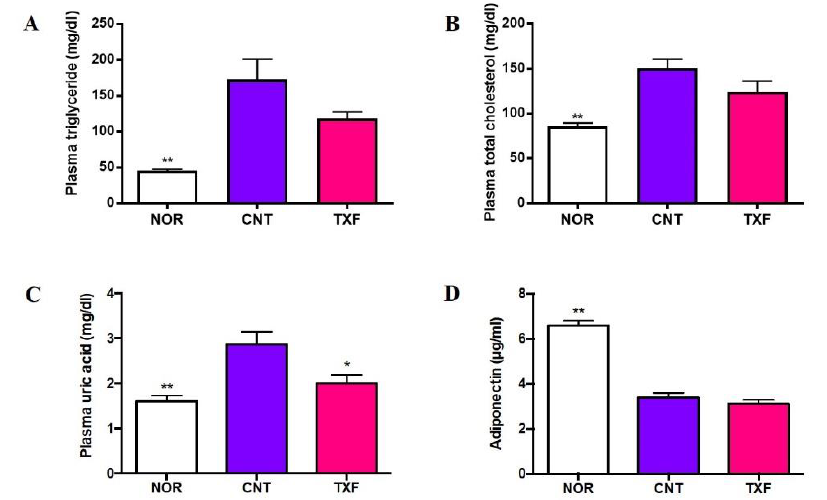
Figure 5. Effect of taxifolin on plasma levels of triglyceride ( A ), total cholesterol ( B ), uric acid ( C ) and adiponectin ( D ) in T2D model KK-A y /Ta mice. At the end of experimental period of four weeks, mice were fasted for 6 h, whole blood was collected from each mouse and plasma sample was prepared. Each value represents the mean ± SEM for eight (Nondiabetic Normal; NOR), seven (Diabetic Control; CNT) or 6 (Diabetic Taxifolin-treated; TXF) mice. *, ** Significantly different from the CNT group at * p < 0.05 and ** p < 0.01, respectively, by Dunnett multiple comparisons test.